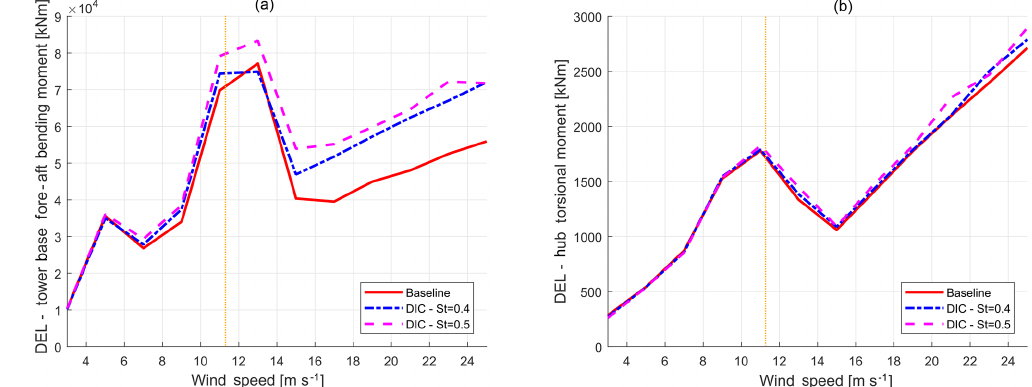
Figure 9. Comparison between tower base fore–aft bending moment (a) and hub torsional moment (b) DEL of the baseline (solid red) and DIC with St = 0 . 4 (dash–dotted blue) and St = 0 . 5 (dashed magenta) as functions of mean wind speed. The dashed yellow line indicates the rated wind velocity. Typically, DIC will only be implemented at below-rated inflow